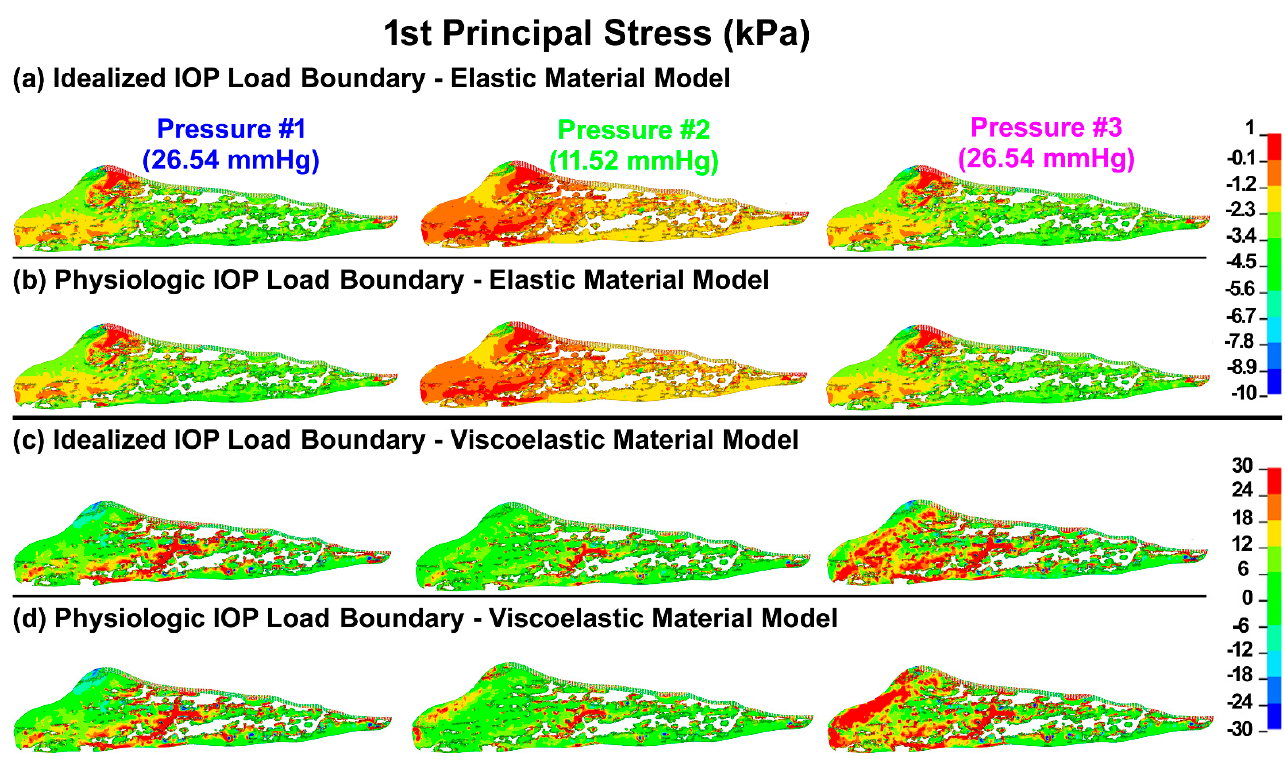
Figure 3. The 1st principal stress in the TM/JCT/SC complex with ( a ) idealized IOP load boundary (elastic material) (pressure t1, pressure t2, pressure t3), ( b ) physiologic IOP load boundary (elastic material), ( c ) idealized IOP load boundary (viscoelastic material), and ( d ) physiologic IOP load boundary (viscoelastic material) at three different IOPs.